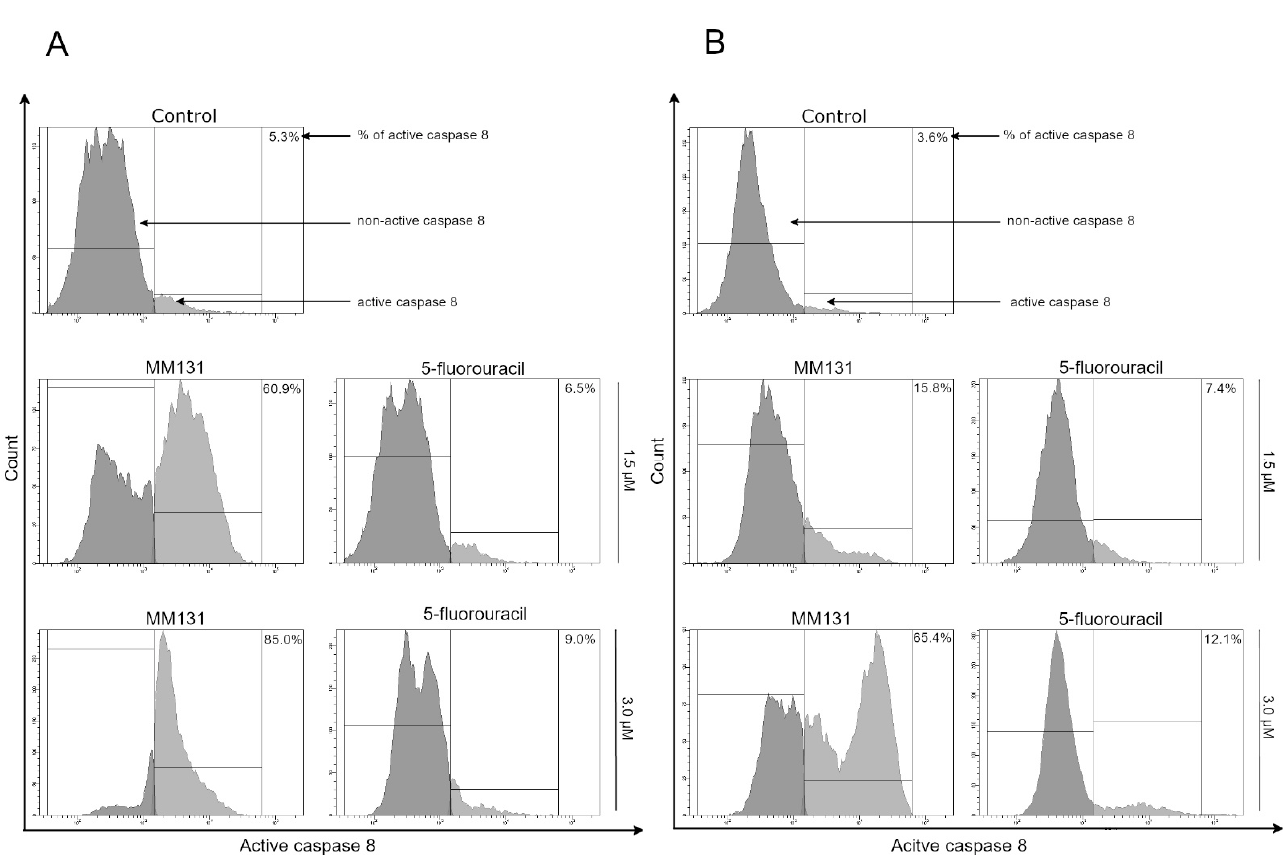
Figure 6. Flow cytometric analysis of caspase-8 activity in DLD-1 ( A ) and HT-29 ( B ) colorectal cancer after 24 h of incubation with MM131 and 5-fluorouracil. The number of cells with active caspase-8 is represented as a mean of three separate experiments.